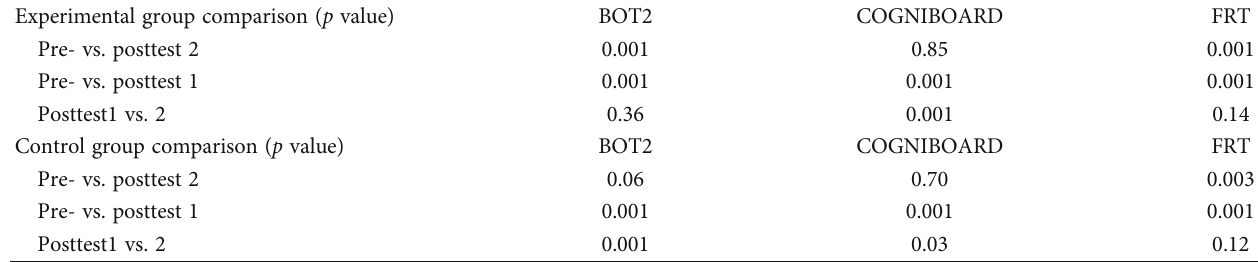
Table 3: Summary of results of post hoc analysis of all the three outcomes in both the